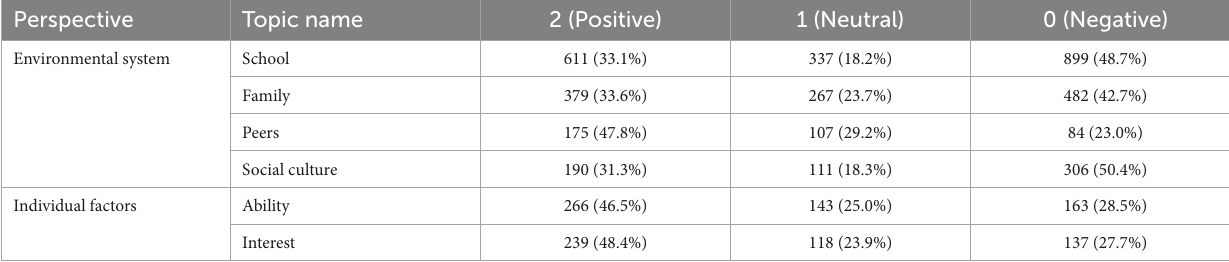
TABLE 3 Results of topic sentiment distribution.